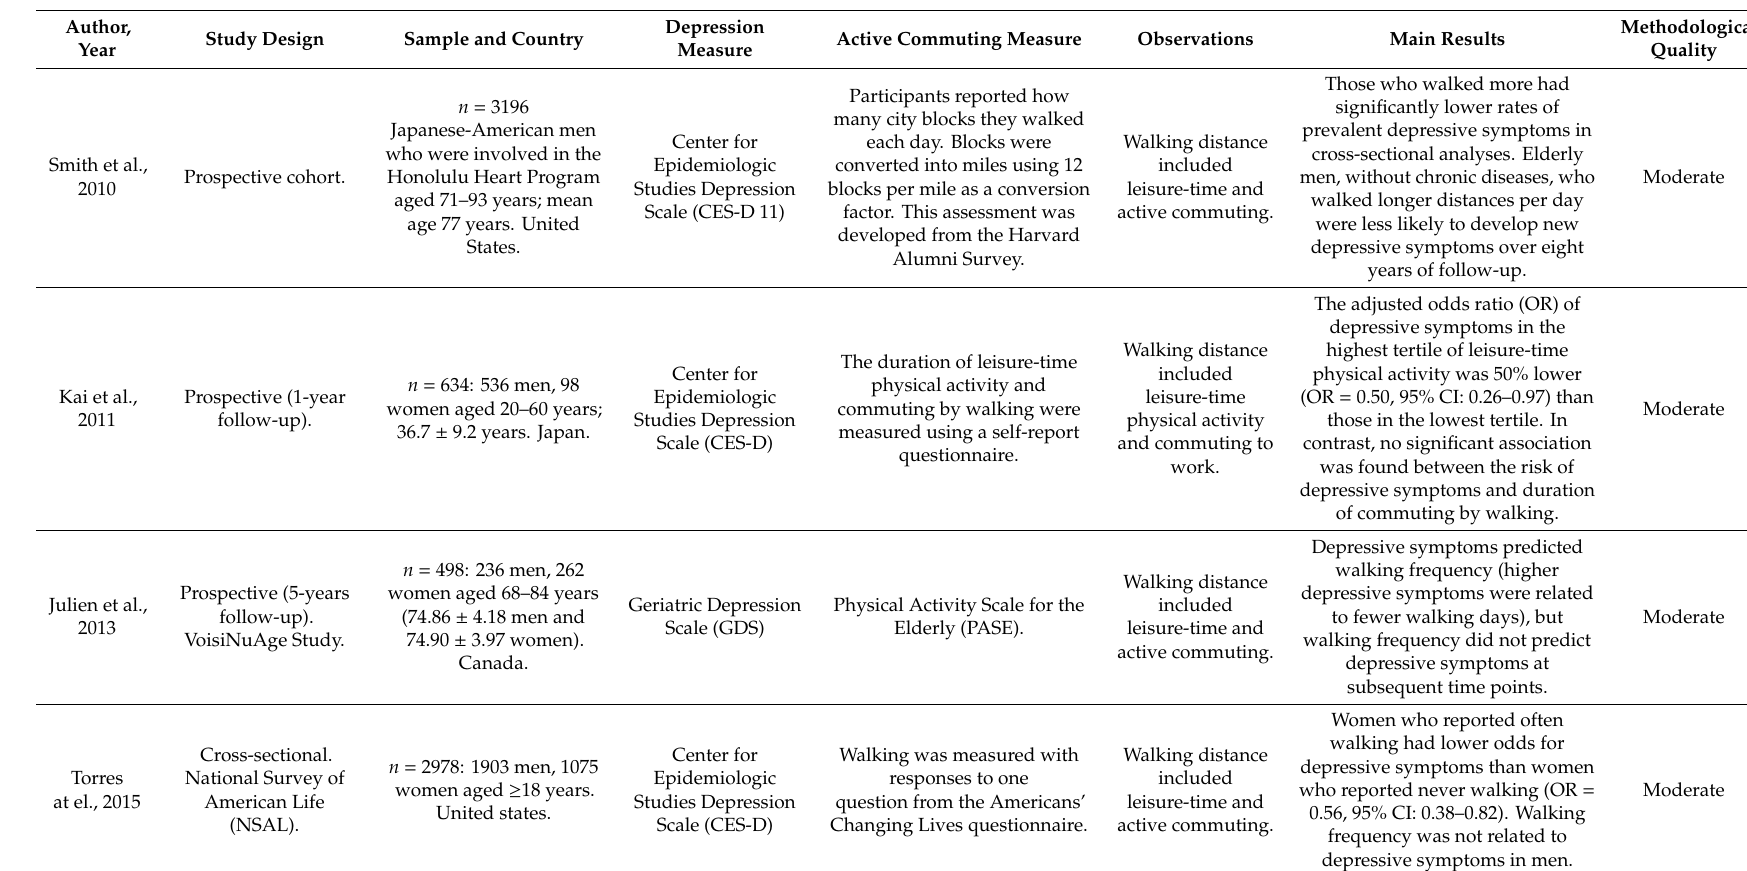
Table 1. Characteristics of the